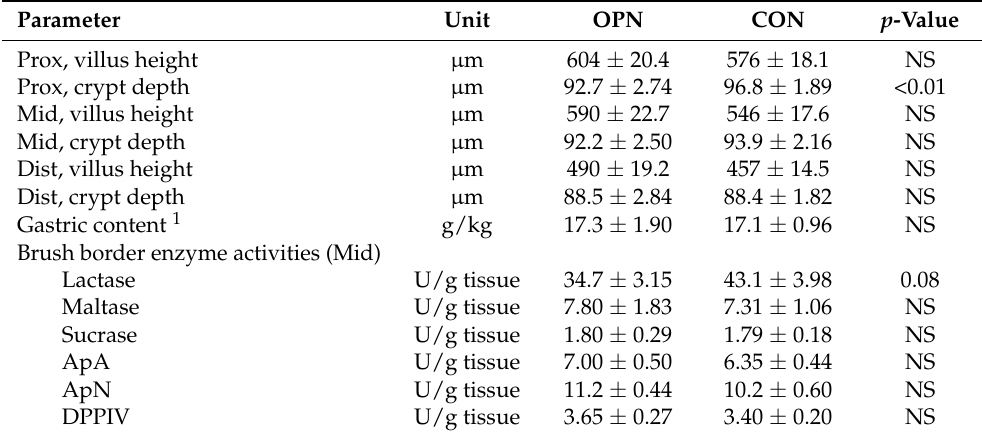
Table 2. Gut structure and function on day 19 of preterm pigs fed a bovine milk diet (CON, n = 19) or the milk diet supplemented with OPN (OPN, n = 16).